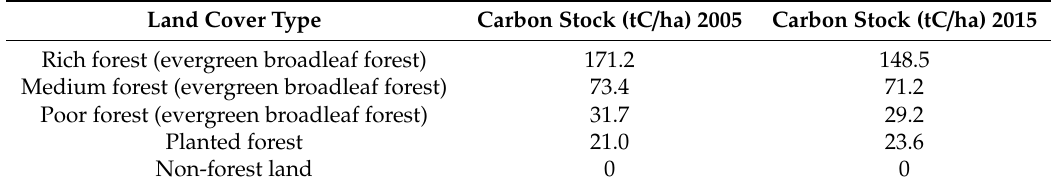
Table 3. Carbon stock estimates for 2005–2015 by land